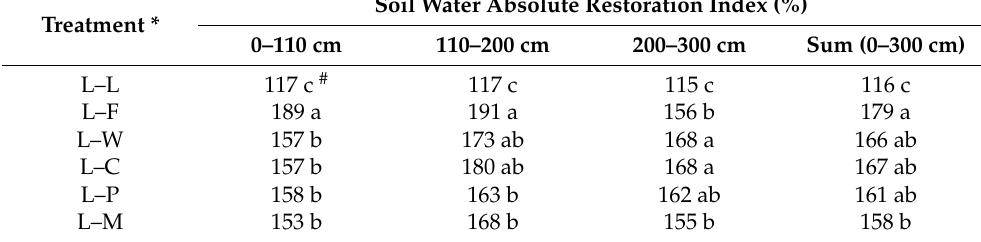
Figure 7. Rate of soil water recovery of lucerne-to-crop conversion in October from 2012 to 2018. Different letters indicate treatment means that are significantly different among treatments in the 0–300 cm soil depth ( p ≤ 0.05). Error bars indicate standard deviations of the means ( n = 3). Treatment abbreviations are defined in Table 1. Table 4. Average soil water absolute restoration index of the crop rotation treatments in October from 2012 to